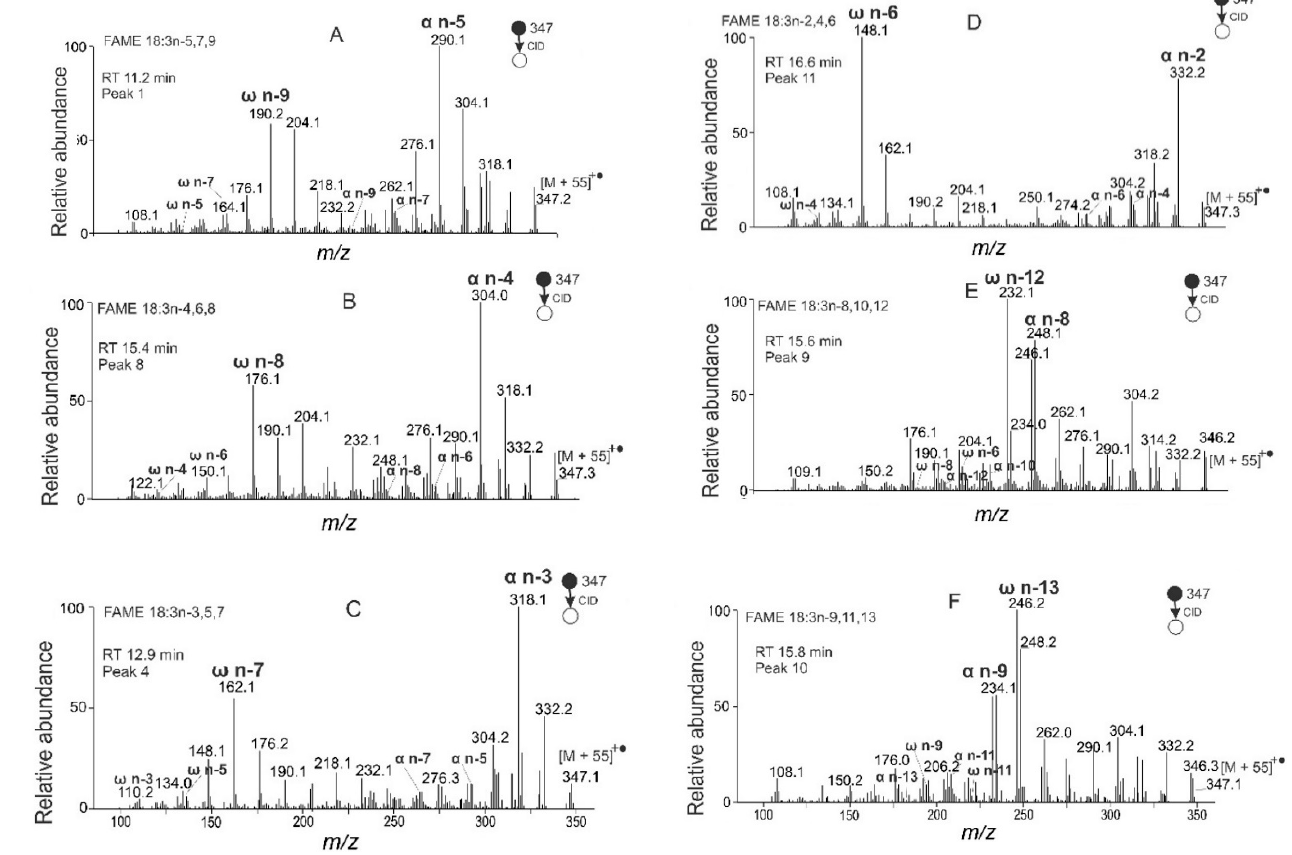
Figure 8. APCI MS/MS spectra of the [M + 55] +• adducts of selected conjugated FAMEs from PSO interpreted as FAME